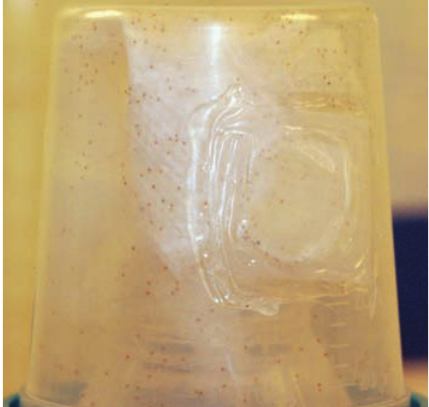
Figure 5: Connection cup with P. persimilis after prey had been depleted. A piece of paper can be introduced to the connection cup to increase the surface area.